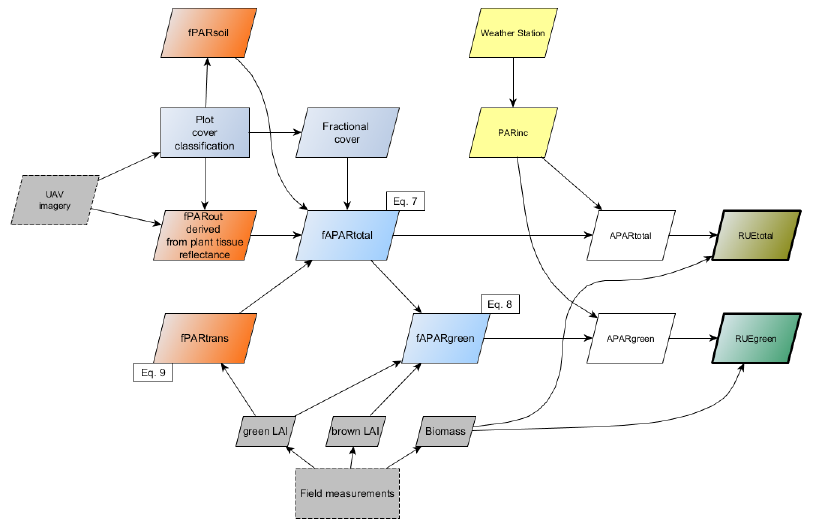
Figure 2. Flowchart of the RUE total and RUE green estimation method.